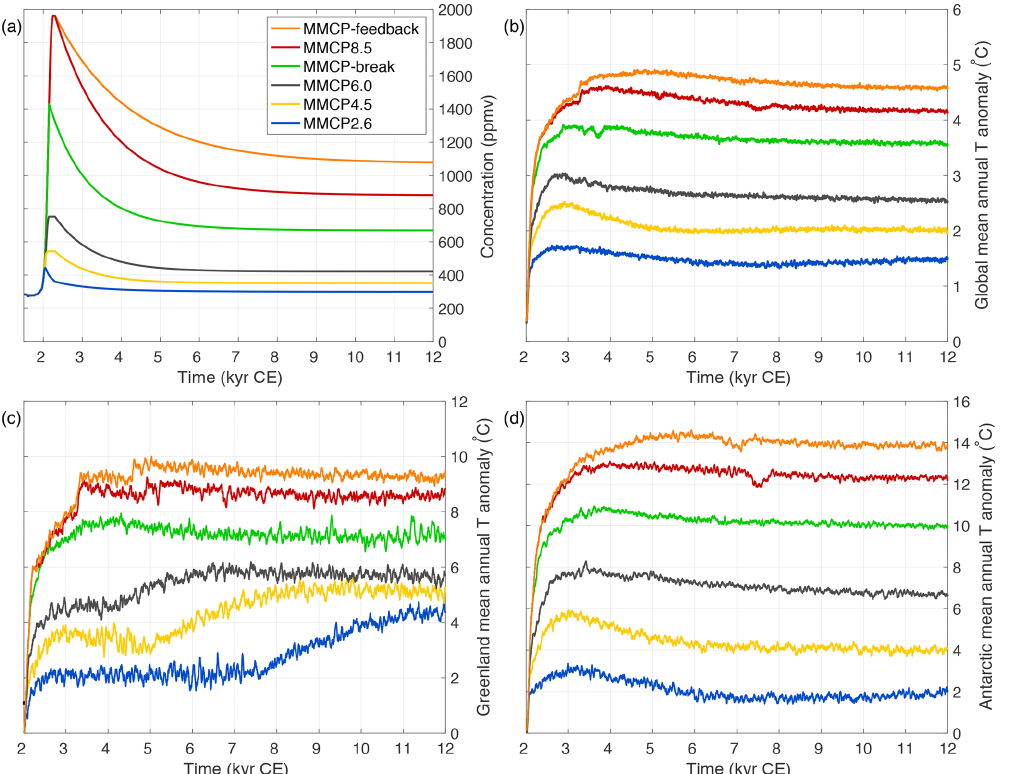
Figure 2. (a) Atmospheric CO 2 concentration scenario from 1500CE to 12000CE for the six different forcing scenarios. (b) Global mean temperature change for the historical period 1500–2000CE and the future projections, (c) Greenland mean temperature change, and (d) Antarctic mean temperature change for the six forcing scenarios. All temperature projections are shown as an anomaly to a reference period